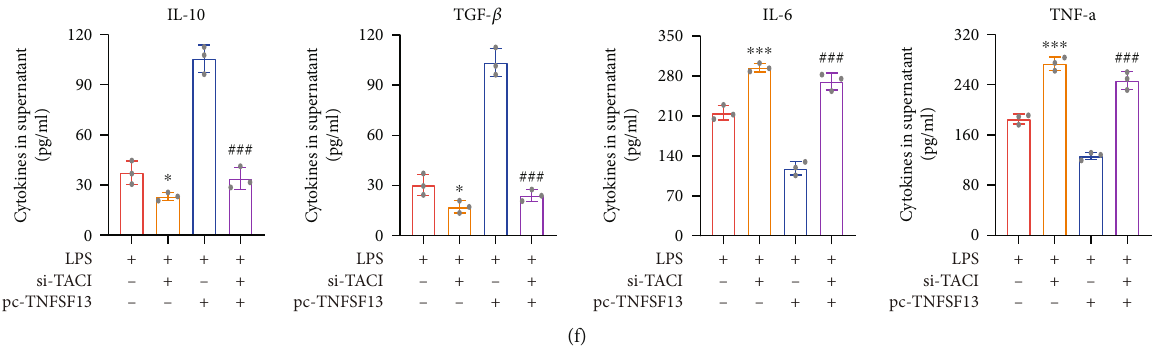
Figure 4: Overexpression of TNFSF13 in IECs induces B cell di ff erentiation via TACI. (a) GSE81211 dataset was used to analyze the genes of high DNA methylation levels in UC, and the screened genes were displayed in heatmap. (b) The intestinal epithelial tissues from mice in the sham and DSS group were collected. TNFSF13 DNA methylation level, mRNA level, and protein level were evaluated. (c) IECs were transfected with pc-TNFSF13 or pc-NC following the treatment of LPS (1 μ g/mL) for 48h. Cells were allocated into 4 groups: IECs, IECs +LPS, IECs-pc-NC+LPS, and IECs-pc-TNFSF13+LPS. The methylation level and mRNA level in IECs and protein level of TNFSF13 in the supernatants were examined. (d) The si-TACI or si-NC was transfected into B cells, and the TACI mRNA and protein levels were detected. (e) Next, IECs with or without pc-TNFSF13 transfection were cocultured with B cells with or without si-TACI transfection. The divided groups were as follows: IECs+B+LPS (TACI was normally expressed in B cells), IECs+B-si-TACI+LPS (TACI was knockdown in B cells), IEC-pc-TNFSF13+B+LPS (TACI was normal expressed in B cells, and TNFSF13 was overexpressed in IECs), and IEC-pc-TNFSF13+B-si-TACI+LPS (TACI was knockdown in B cells, and TNFSF13 was overexpressed in IECs) groups. The numbers